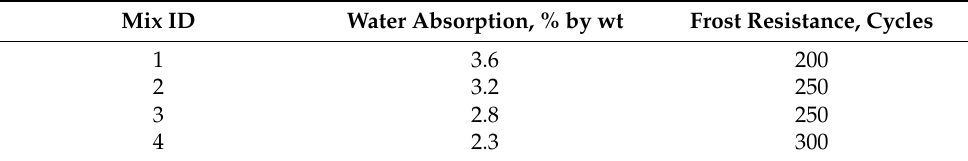
Table 4. Frost resistance and water absorption of the mortars.